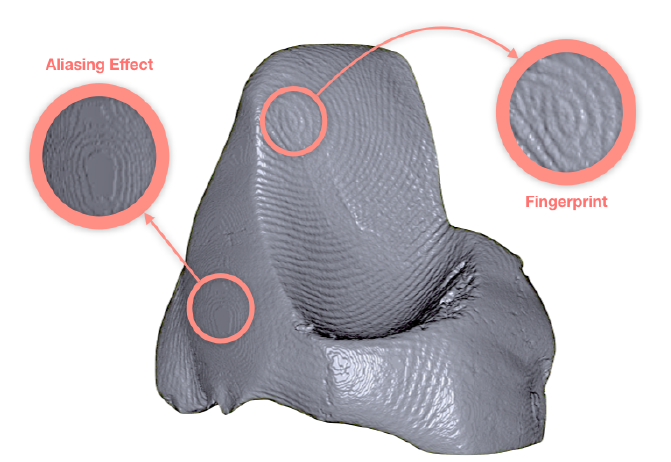
Figure 10. Fingerprints and the aliasing effects highlighted in the play-dough sample, in a scan comparable the terracotta